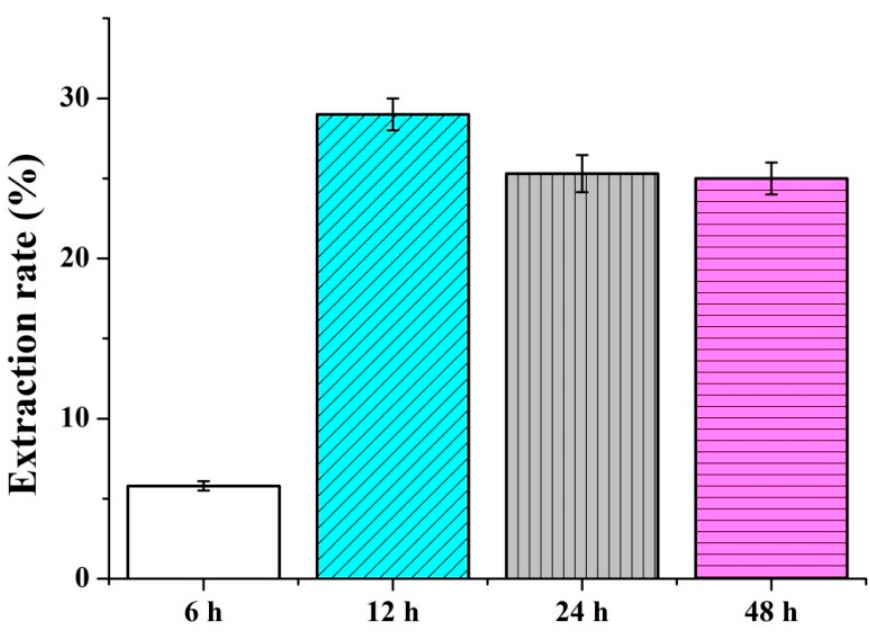
Figure 2. Calibration analysis of P. emblica powders.